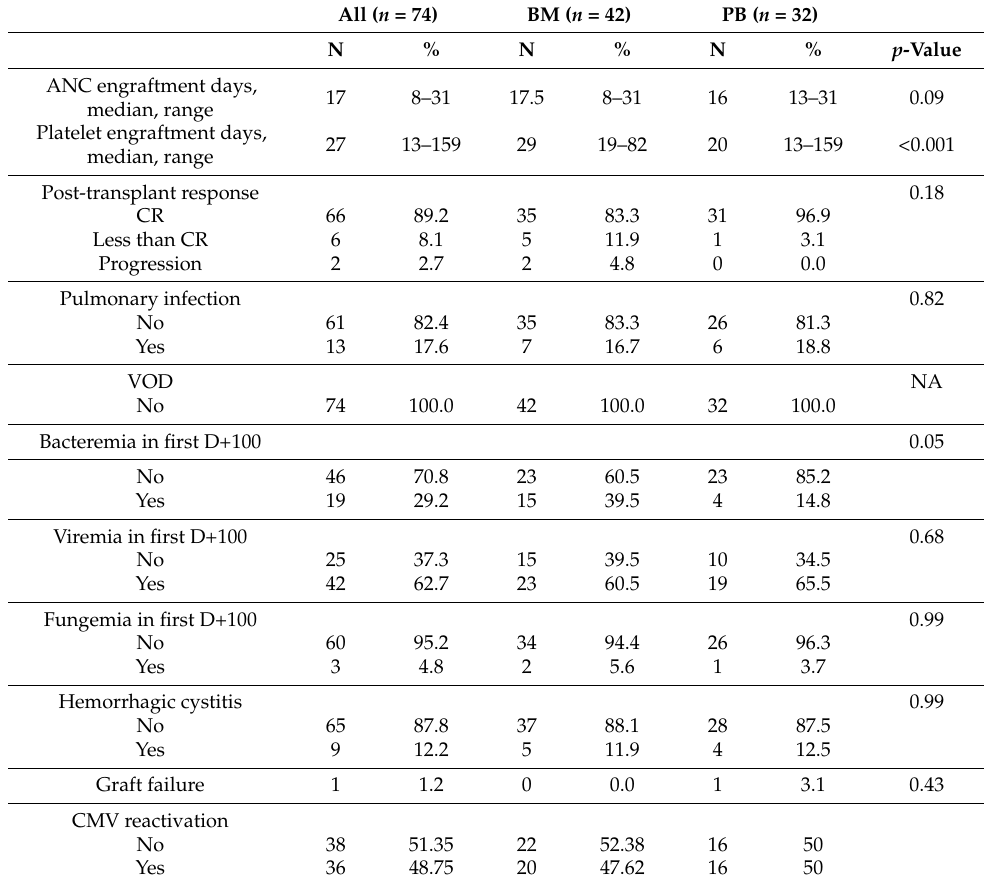
Table 2. Transplant outcomes of haploidentical donor with BM and